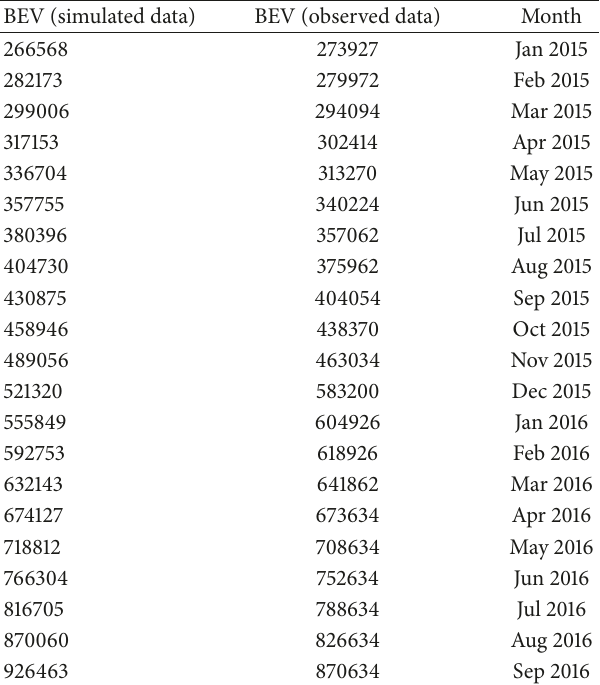
Table 2: Simulated result of BEV based on Bass model.